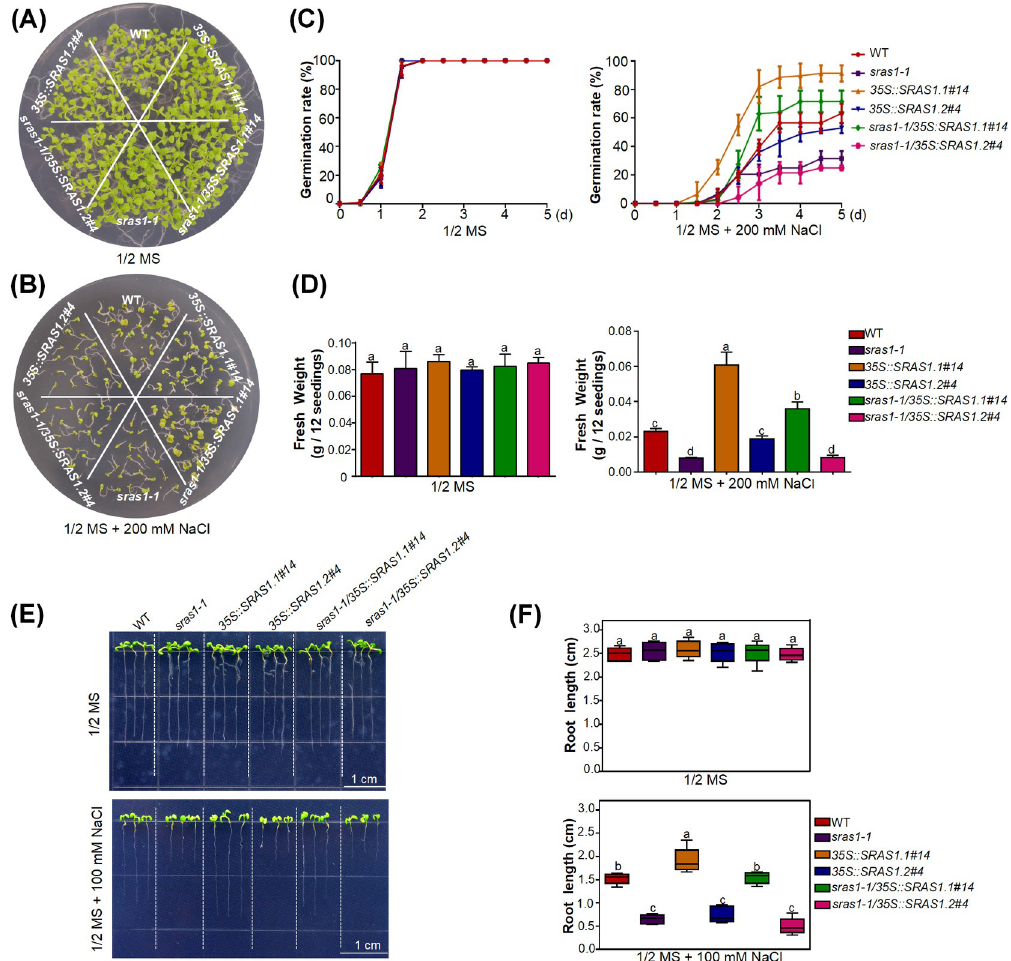
Fig 3. SRAS1 is involved in the salt stress response. Germination phenotype of WT, sras1-1 , 35S :: SRAS1 . 1 , 35S :: SRAS1 . 2 , sras1-1/35S :: SRAS1 . 1 and sras1-1/35S :: SRAS1 . 2 seedlings grown on 1/2 MS medium. Images were taken 10 days after germination. Germination phenotype of WT, sras1-1 , 35S :: SRAS1 . 1 , 35S :: SRAS1 . 2 , sras1-1/35S :: SRAS1 . 1 and sras1-1/35S :: SRAS1 . 2 seedlings grown on 1/2 MS medium with 200 mM NaCl. Images were taken 10 days after germination. Germination rates of WT, sras1-1 , 35S :: SRAS1 . 1 , 35S :: SRAS1 . 2 , sras1-1/35S :: SRAS1 . 1 and sras1-1/35S :: SRAS1 . 2 seedlings grown on 1/2 MS medium with or without 200 mM NaCl. The values are the mean ± standard deviation from three biological replicates. (D) Fresh weight of WT, sras1-1 , 35S :: SRAS1 . 1 , 35S :: SRAS1 . 2 , sras1-1/35S :: SRAS1 . 1 and sras1-1/35S :: SRAS1 . 2 seedlings. Error bars indicate SD (n = 60). Different letters indicate that values were significantly different at P < 0.01. (E) Root growth of WT, sras1-1 , 35S :: SRAS1 . 1 , 35S :: SRAS1 . 2 , sras1-1/35S :: SRAS1 . 1 and sras1-1/35S :: SRAS1 . 2 in 1/2 MS medium. Seedlings grown in normal 1/2 MS medium for 3 d were transferred onto 1/2 MS medium with or without 100 mM NaCl and grown for another 7 d. Scale bar = 1 cm. (F) Measurement of root length of the plants shown in (E). Error bars = SE (n > 40 per genotype). Different letters indicate that values were significantly different at P < 0.01. The data shown are representative of three independent experiments. https://doi.org/10.1371/journal.pgen.1009898.g003 SRAS1 . 1 lines overexpressing full-length SRAS1 . 1 CDS 666nt ( 35S :: SRAS1 . 1#14 , 35S :: SRAS1 . 1#26 ) and two 35S :: SRAS1 . 2 lines overexpressing truncated SRAS1 . 2 CDS 180nt ( 35S :: SRAS1 . 2#1 , 35S :: SRAS1 . 2#4 ) were used for further study (S2B and S2C Fig). WT, sras1-1 , 35S : SRAS1 . 1 and 35S : SRAS1 . 2 overexpression transgenic seeds were germinated on half-strength Murashige and Skoog (1/2 MS) medium containing 0 or 200 mM NaCl. The germination rate of SRAS1 . 1 overexpression lines was higher than that of WT, whereas SRAS1 . 2 overexpression lines germinated less efficiently. In the presence of 200 mM NaCl, after 5 days, 28.5% of sras1-